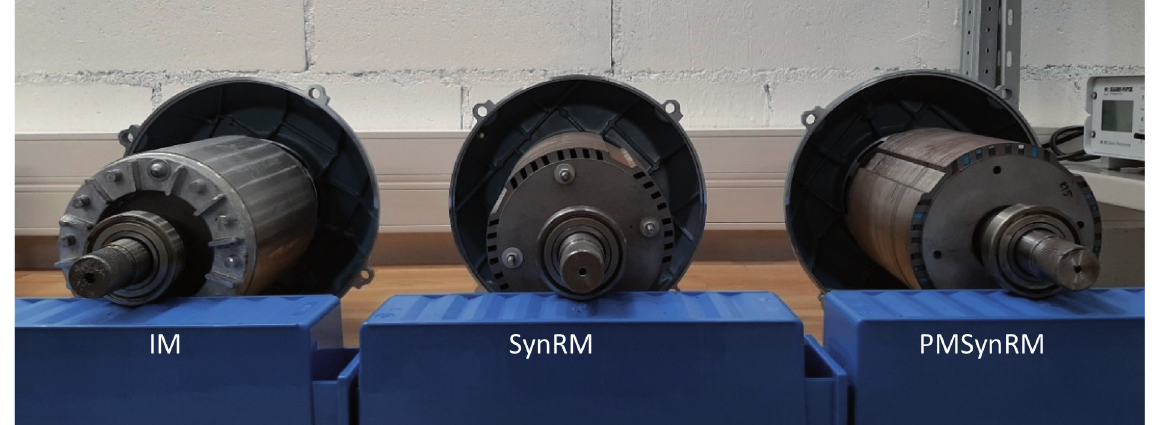
Fig. 2. Rotors of the tested electrical machines front